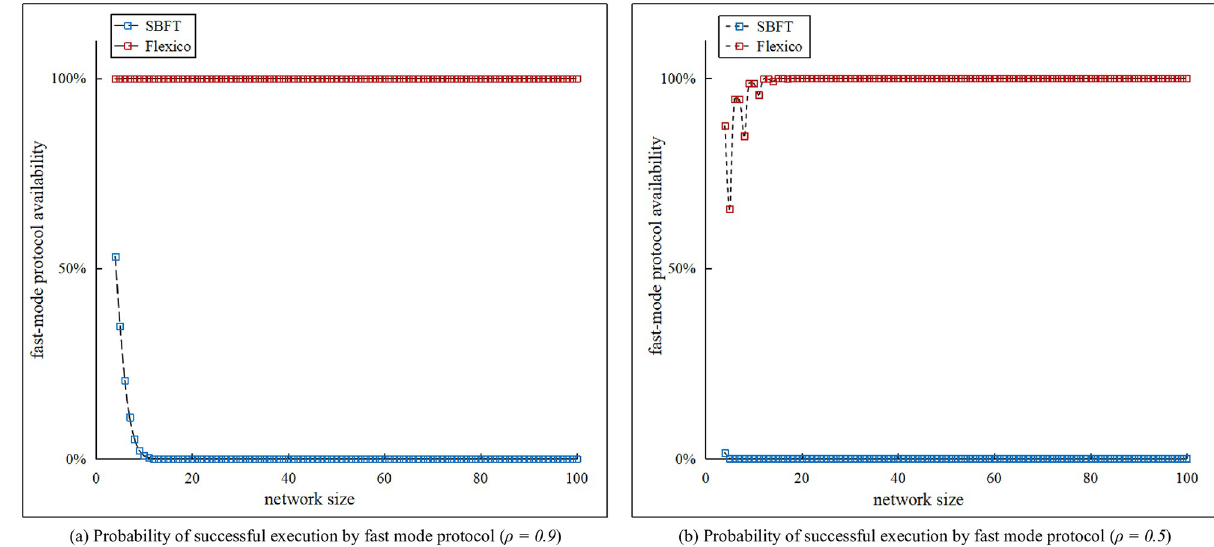
Fig 6. Analysis of fast-mode protocol availability against different network sizes.